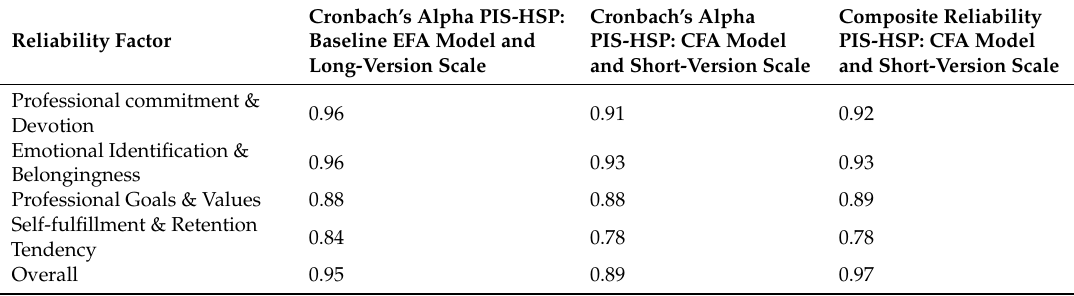
Table 5. Cronbach’s alphas and composite reliability coe ffi cients of the baseline EFA model and the CFA model for the PIS-HSP.